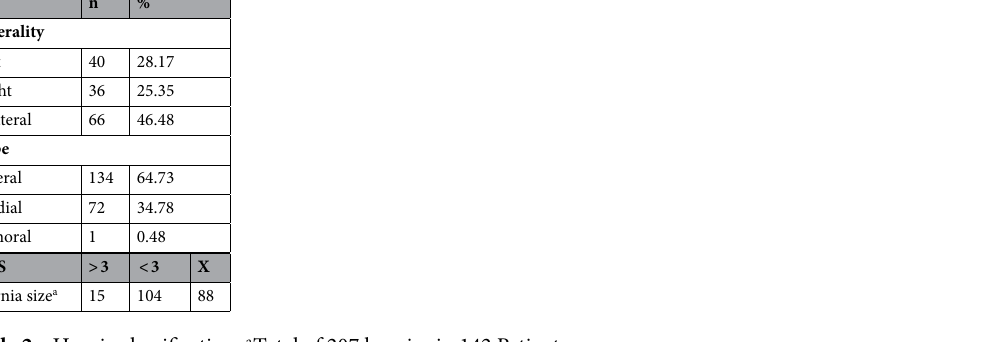
Table 2. Hernia classification. a Total of 207 hernias in 142 Patients.